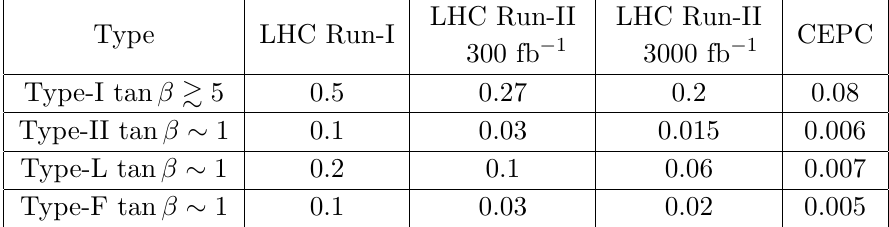
Table 3 . Maximally allowed j cos( (cid:12) (cid:0) (cid:11) ) j range at 95% C.L. given LHC and CEPC Higgs precision